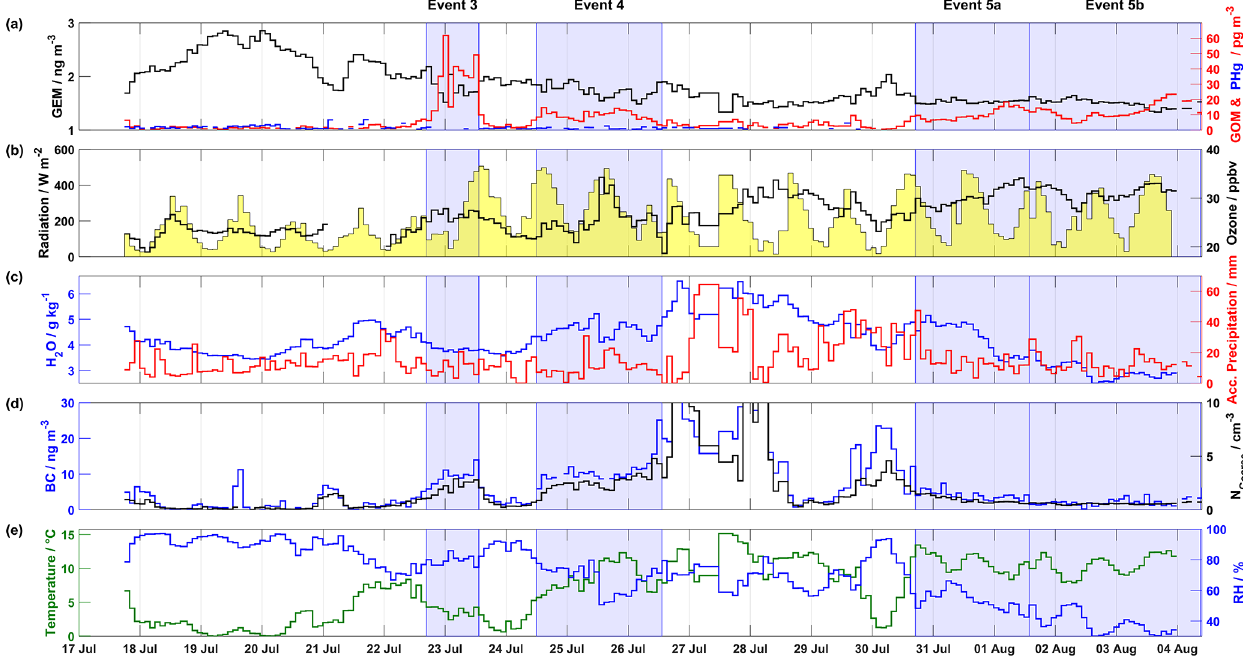
Figure 2. Overview of mercury, meteorological parameters, ozone, and aerosol properties (BC and N Coarse ) measured during the 2020 campaign, including (a) GEM (ngm − 3 ) in black on the left axis, GOM (pgm − 3 ) in red and PHg (pgm − 3 ) in blue on the right axis, (b) radiation (Wm − 2 ) shaded in yellow on the left axis and ozone (ppbv) in black on the right axis, (c) H 2 O mixing ratio (gkg − 1 ) at ground level in blue on the left axis and accumulated precipitation (mm) in red on the right axis, (d) BC (ngm − 3 ) in blue on the left axis and N Coarse (cm − 3 ) in black on the right axis, and (d) temperature ( ◦ C) in green on the left axis and relative humidity (%) in blue on the right axis. The areas shaded in blue indicate Events 3, 4, 5a, and 5b. The axis scale for (d) is truncated to show the fine structure of BC and N Coarse during event periods; for the full scale see Fig.